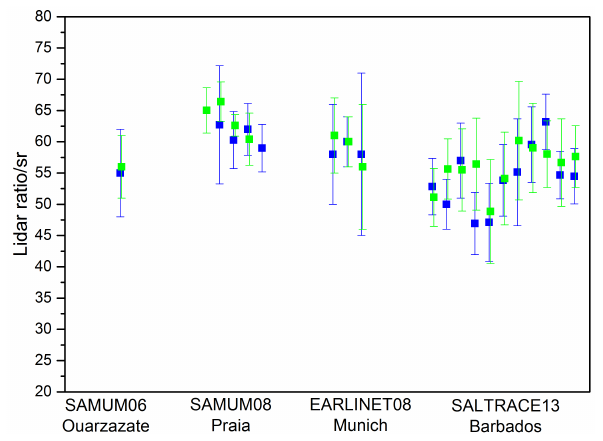
Figure 13. Mean values of the lidar ratio of Saharan dust at 355nm (blue) and 532nm (green) derived for fresh Saharan dust (mean campaign value) during SAMUM-1 in Ouarzazate, Morocco, in 2006 (SAMUM06) (Tesche et al., 2009b); for mid-range trans- ported Saharan dust on 5 days during SAMUM-2 in Cape Verde in 2008 (SAMUM08) (Groß et al., 2011b); for long-range trans- ported dust over Central Europe on 3 days in Munich, Germany, in 2008 (EARLINET08) (Wiegner et al., 2011); and for long-range transported Saharan dust over the Caribbean on 10 days during SALTRACE in Barbados in 2013 (SALTRACE13). The error bars denote the systematic errors.